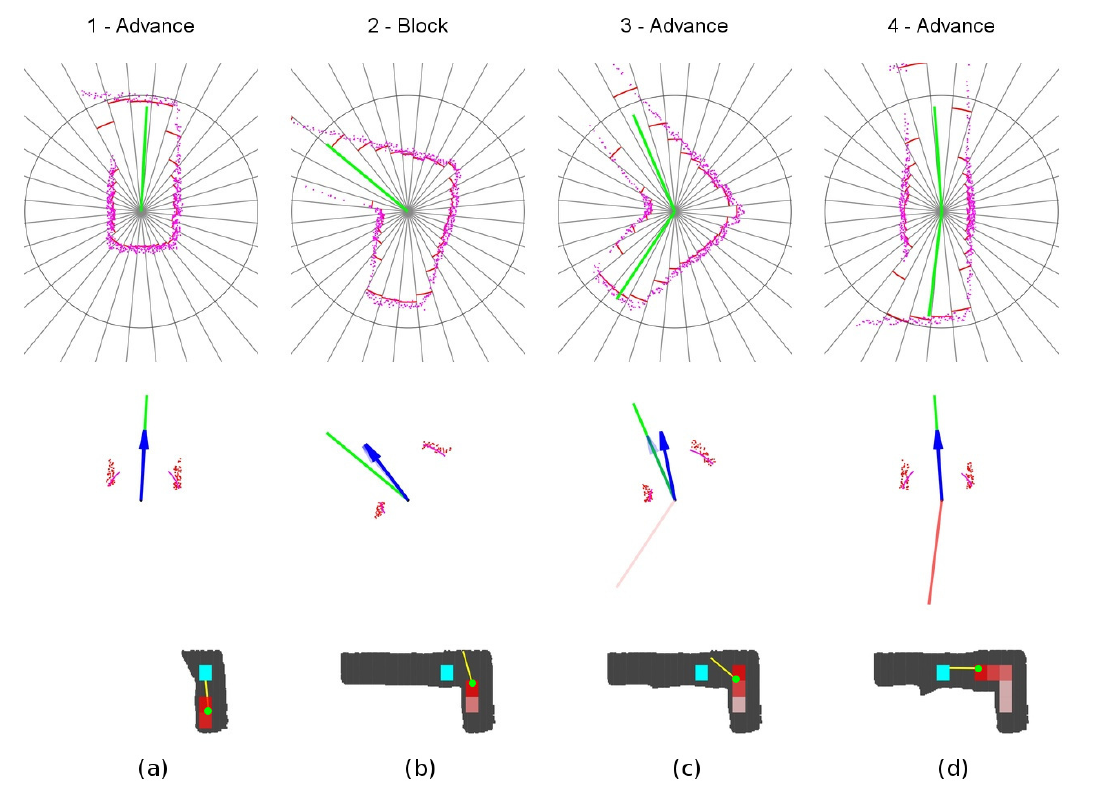
Figure 14. Unexplored corner secuence of events. ( a ) Location 1. ( b ) Location 2. ( c ) Location 3. ( d ) Location 4.